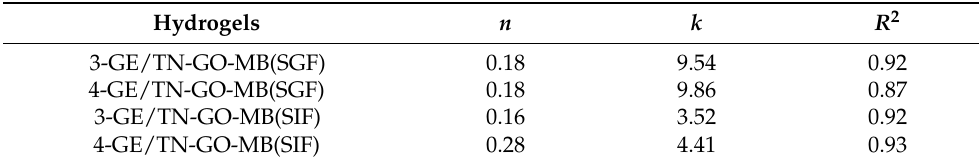
Table 2. Values of the diffusional exponent ( n ) and constant ( k ) obtained by application of the Ritger–Peppas model in the MB release curves obtained in SGF and SIF at 37 ◦ C (Figure 9).